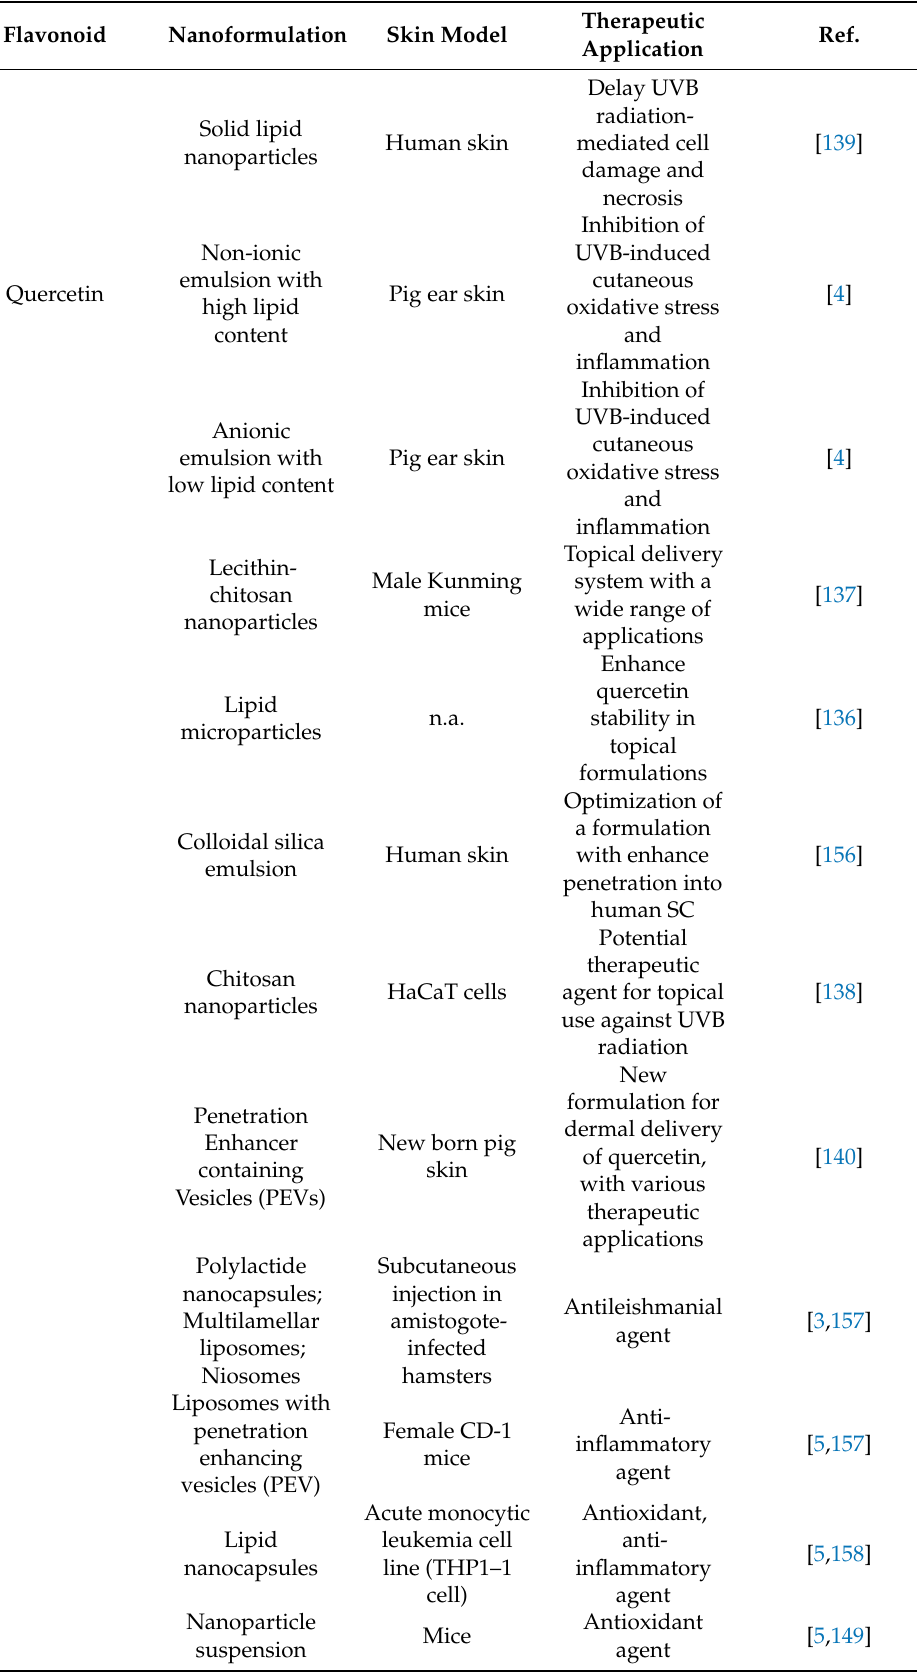
Table 3. In vitro and in vivo studies using different nanocarriers for enhanced topical delivery of flavonoids to the